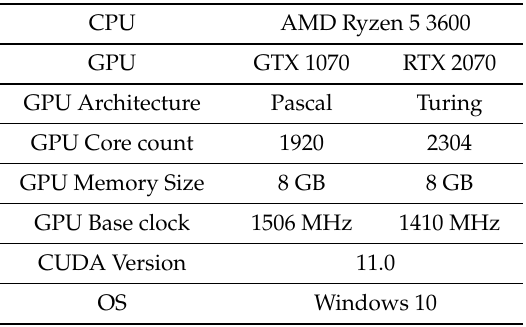
Table 3. GPU optimization implementation test environment.